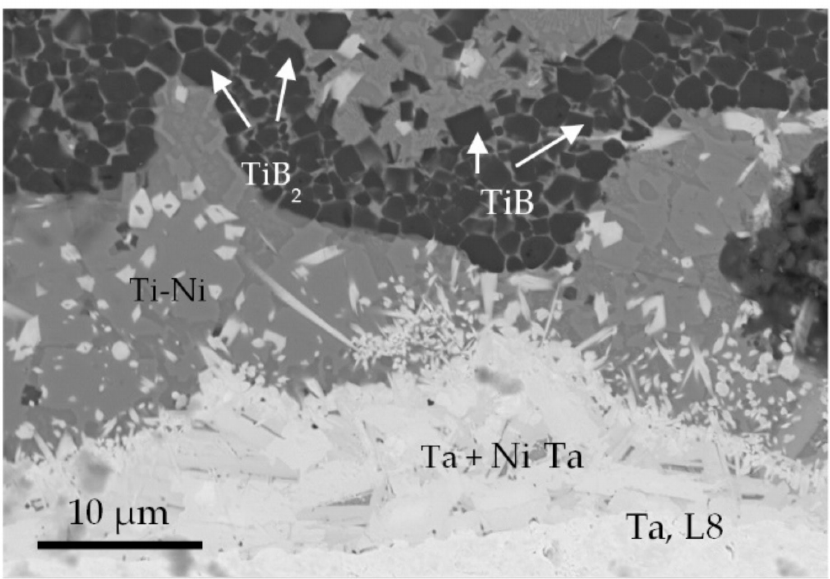
Figure 8. Microstructure of cermet–Ta joint (zone L5–L8, cross section of Set 1 ).